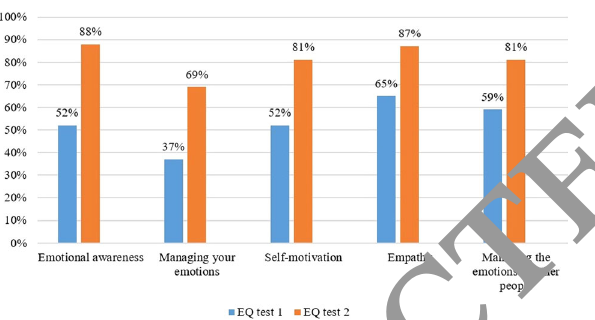
Fig. 2 The percentage of positive EQ Scores before and after